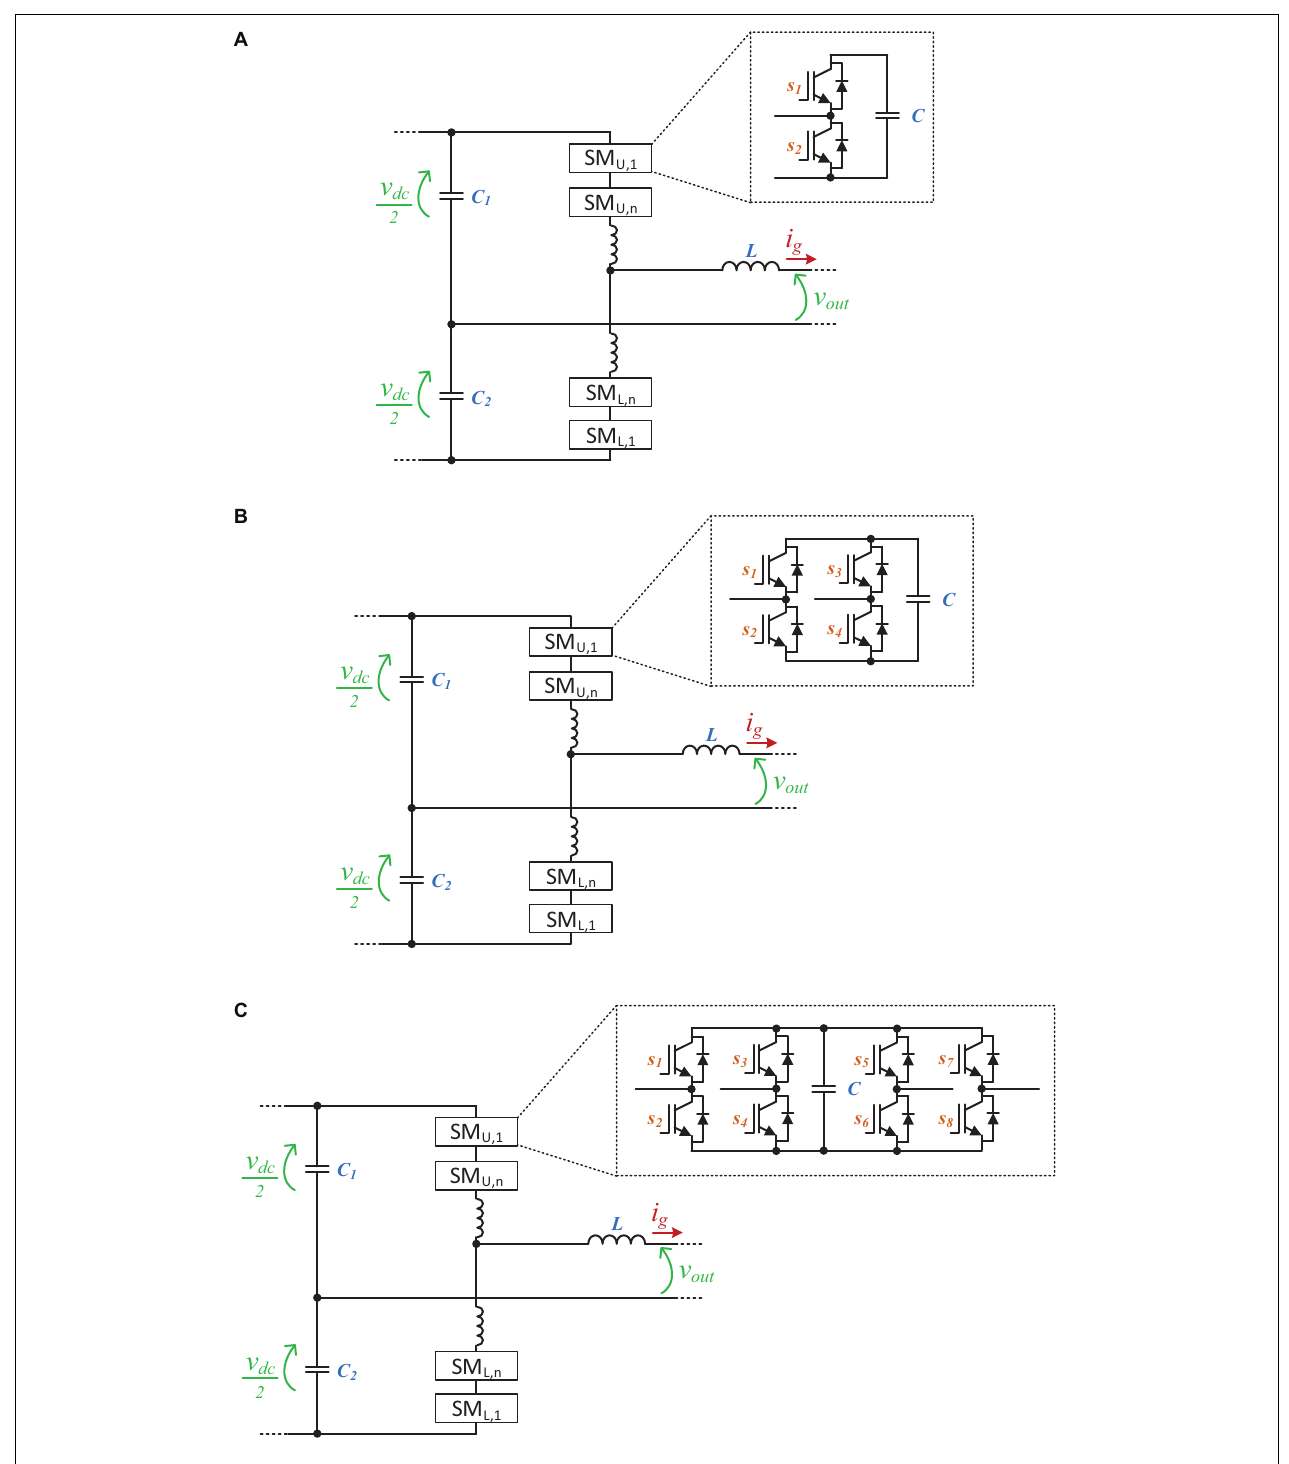
FIGURE 11 | MMC topologies: (A) proposed in Zhou et al. (2018); (B) proposed in Hu et al. (2018); (C) proposed in Goetz et al. (2015).